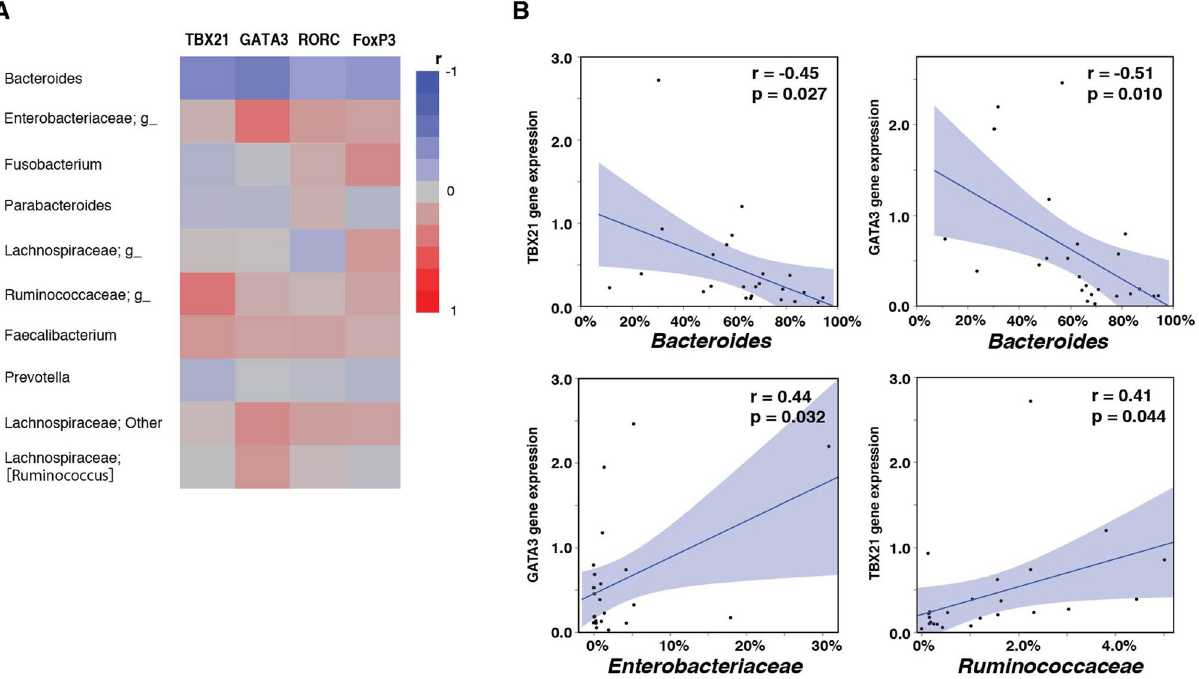
Figure 4. Correlation between the expression of Th-/Treg-related genes and proportion of top 10 microbes in endoscopic remission group. (A) Heat map of correlation between expression of T helper (Th) cell / regulatory T (Treg) cell-related genes and proportion of top 10 microbes in endoscopic remission group. (B) Correlation between expression of Th-/Treg-related genes and proportion of microbes. The shadow represents the 95% confidence interval of the regression